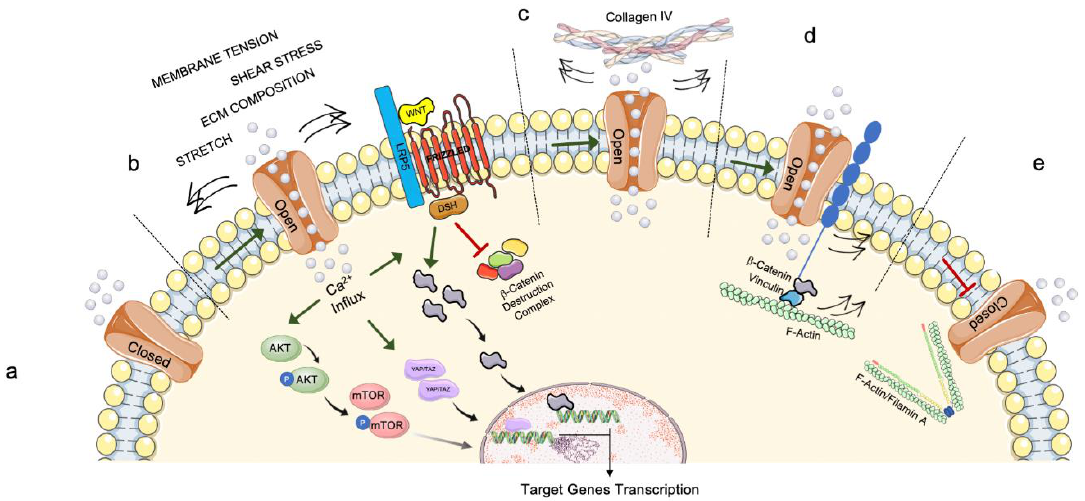
Figure 1. Schematic representation of mechanical regulation of Piezo channels: ( a ) When no stimuli are present, Piezo channels are closed and inhibit the passage of ions; ( b ) Different mechanical cues stimulate Piezo opening through forces that are conveyed by the stretching of the lipid bilayer and allow the entering of positive ions such as Calcium inside the cell where it triggers pathways such as Akt/mTOR, YAP/TAZ and Wnt/ β -Catenin, allowing the transcription of target genes; ( c ) Collagen IV presence in the ECM induces Piezo opening; ( d ) Piezo interacts with the E-Cadherin/ β -Catenin/F-Actin complex which generates intracellular forces that favor the channels’ opening; ( e ) Piezo interaction with Filamin A is desensitizing and inhibits its opening. AKT, RAC-alpha serine/threonine-protein kinase; Ca 2+ , Calcium ion; DSH, Dishevelled; ECM, extracellular matrix; LRP5, LDL Receptor Related Protein; mTOR, Mammalian target of rapamycin; TAZ, transcriptional co-activator with PDZ-binding motif; WNT, Wingless/Integrated; YAP, Yes-associated protein 1.